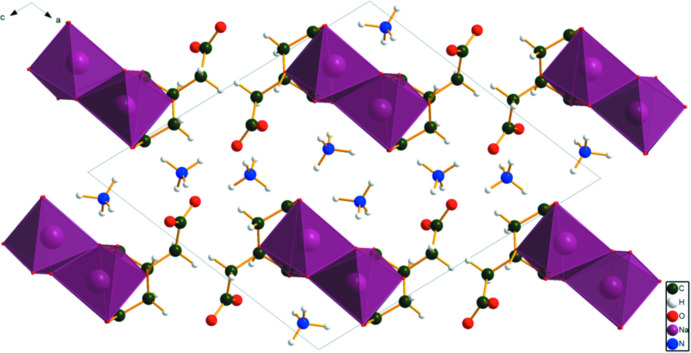
The crystal structure of (II), viewed down [010].